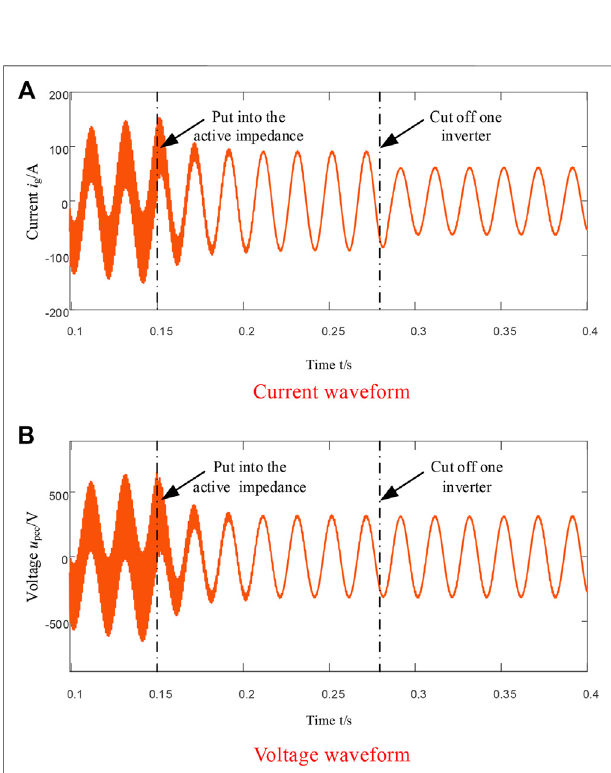
FIGURE 18 | Simulation waveform of voltage and